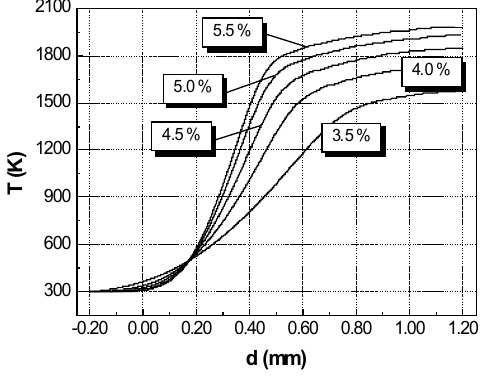
Figure 8. The flame thickness of C